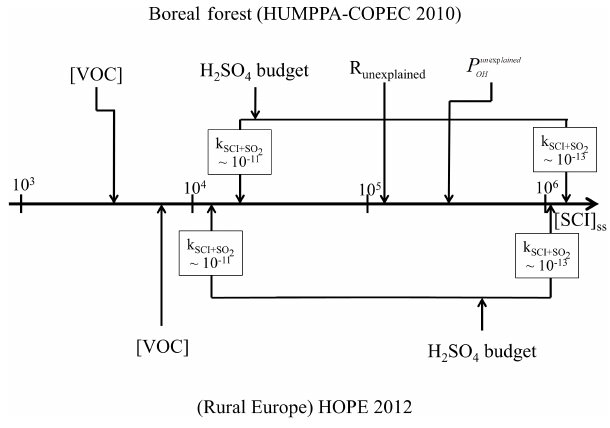
Figure 3. Schematic overview of the estimated steady-state con- centration of SCIs ([SCI] ss , moleculescm − 3 ) observed during the HUMPPA-COPEC 2010 and HOPE 2012 campaigns. For both campaigns the SCI estimate is based on the unsaturated VOC con- centration measured, [VOC], and the H 2 SO 4 budget using different SCI + SO 2 rate coefficients ( k SCI + SO in cm 3 molecule − 1 s − 1 ) . In 2 addition, during the HUMPPA-COPEC campaign SCIs can be cal- culated from the unexplained OH reactivity, R unexplained , and unex- plained OH production, P OH . See main text for more details unexplained (Sect.